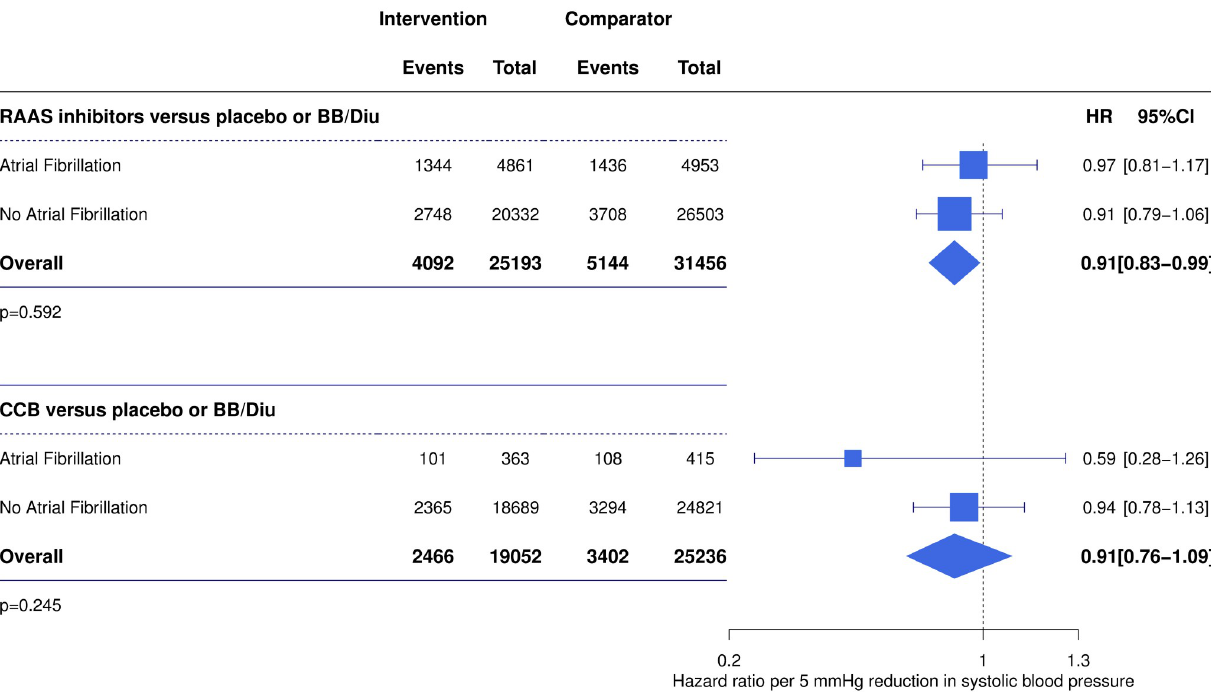
Fig 6. Effect of blood pressure-lowering treatment on major cardiovascular events stratified by drug class. Forest plot displays the HRs and 95% CIs for major cardiovascular events for a 5-mm Hg systolic blood pressure reduction for RAAS inhibitors-based and CCB-based regimens in comparison with placebo or BB with or without Diu. P values for test of difference between subgroups. BB, beta-blocker; CCB, calcium channel blocker; CI, confidence interval; Diu, diuretic; HR, hazard ratio; RAAS, renin-angiotensin-aldosterone system.